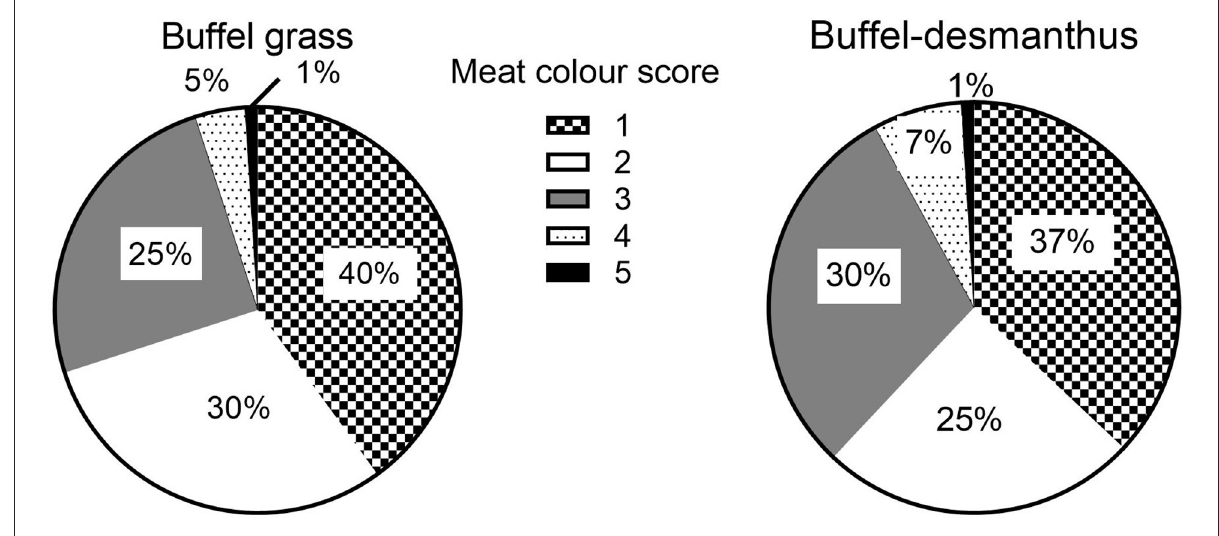
FIGURE2 Effect of backgrounding pasture on steer meat color score ( p = 0.57).